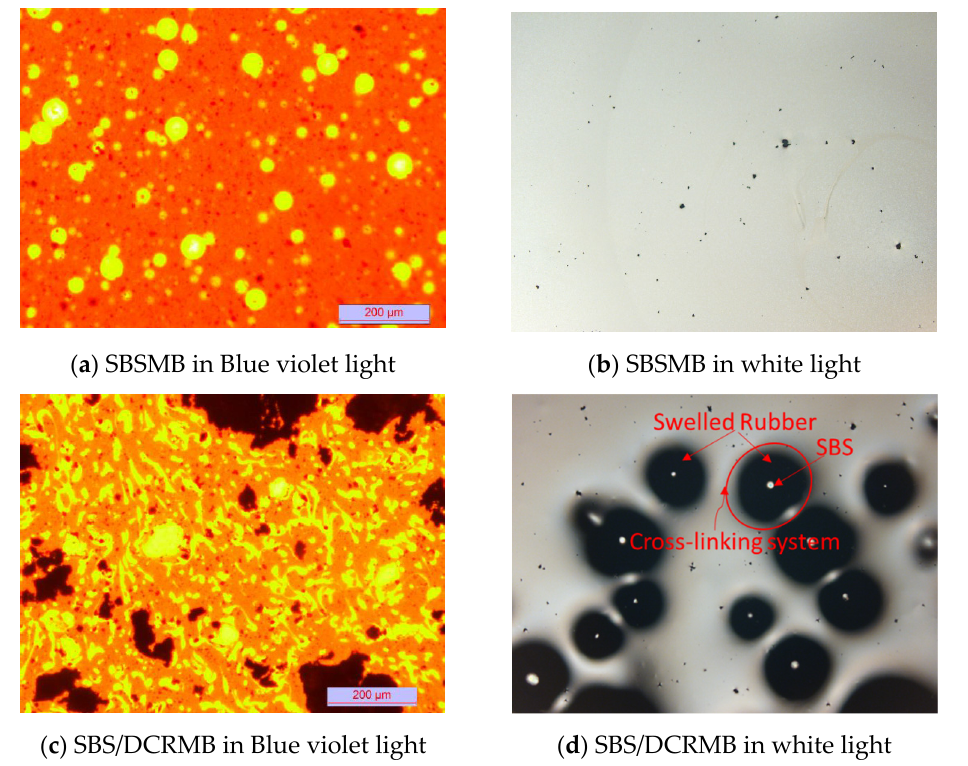
Figure 3. Micrography of SBSMB ( a , c )and SBS/DCRMB ( b , d ) with different magnifications and different light sources in Fluorescence.